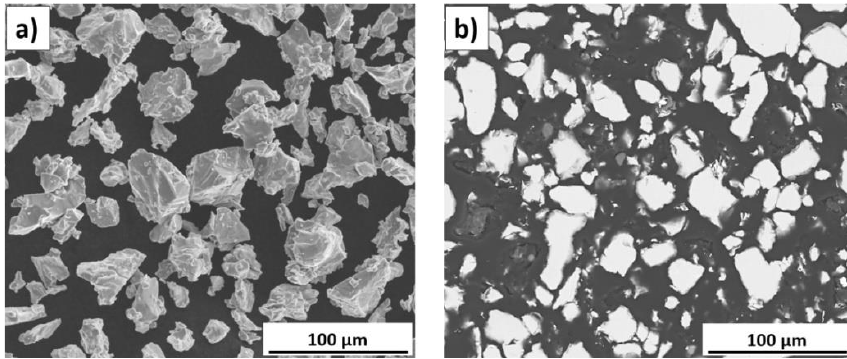
Figure 1. The titanium powder: ( a ) morphology, ( b ) cross-section.